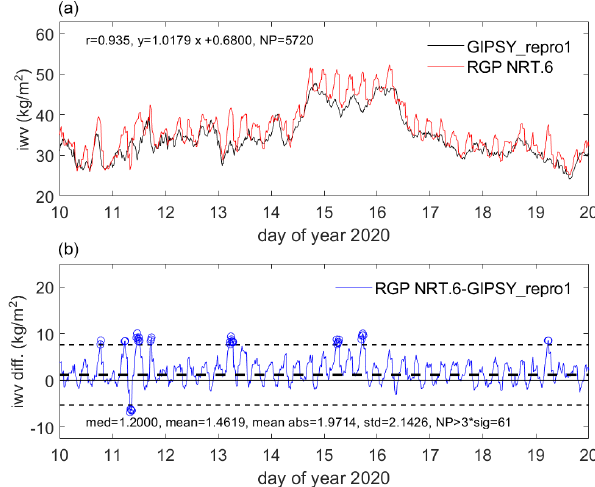
Figure 4. Time series of IWV from near-real-time GNSS process- ing (RGP NRT.6) compared to post-processed GNSS (GIPSY re- pro1) from 10 to 20 January 2020. Panel (a) shows the IWV time series and panel (b) the IWV difference (NRT minus